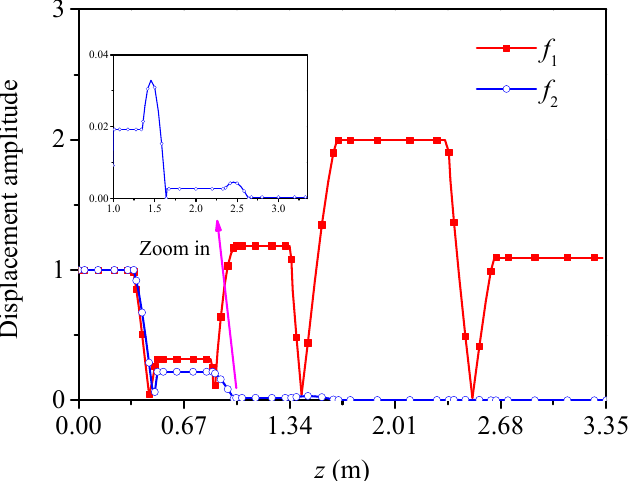
Figure 7. Displacement amplitude of nodes along the z direction of the combined layered periodic foundation under excitation frequencies f 1 and f 2 .